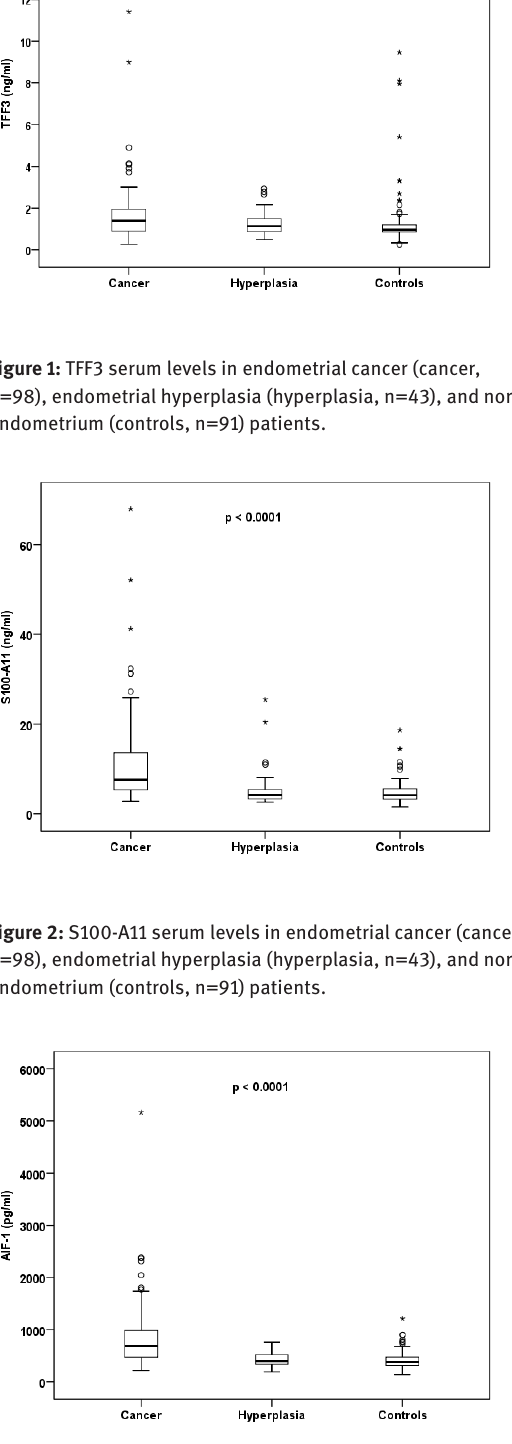
Figure 3: AIF-1 serum levels in endometrial cancer (cancer, n=98), endometrial hyperplasia (hyperplasia, n=43), and normal endometria (controls, n=91)